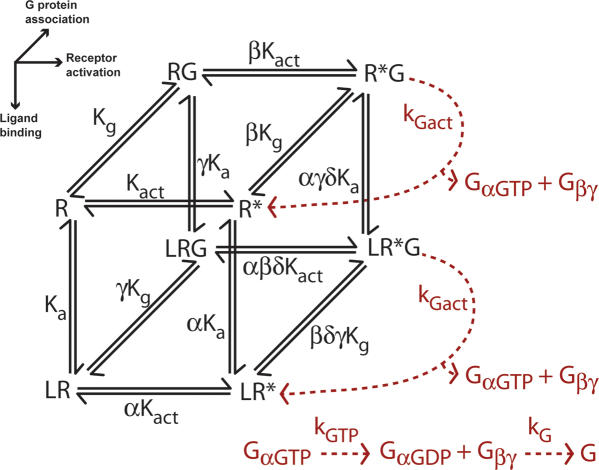
The Cubic Ternary Complex Model and the Cubic Ternary Complex Activation ModelThe cTCM (black) is a thermodynamically complete equilibrium representation of ligand (L), receptor (R), and G protein (G) interactions [11]. Association and dissociation of L and R is represented here from top to bottom, R and G interactions from front to back, and the interconversion of inactive and active R states from left to right of the cube. Based on the cTCM, the cTCAM (black and red) incorporates the dynamics of activation and recycling of G protein (dashed lines) into a kinetic model of LRG interactions [22]. A brief summary of model parameters is found in Table 1. Description of model parameters, assumptions, and equations are given in Text S1.